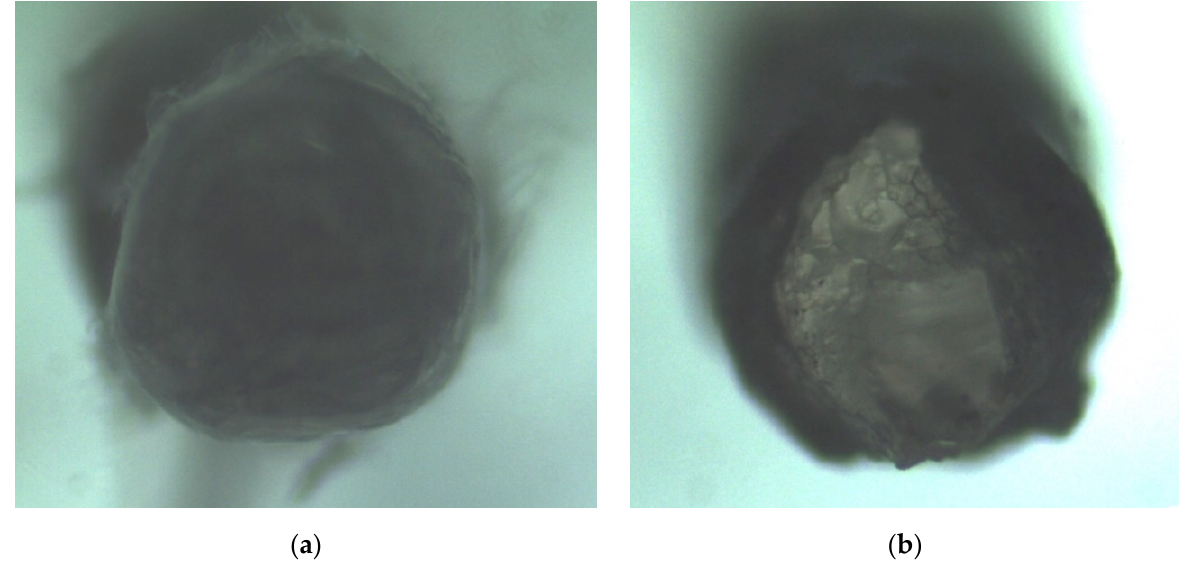
Figure 7. Image of the tip of a coated fiber ( a ) before exposure and ( b ) after exposure for 20 s with a power of 3 W.